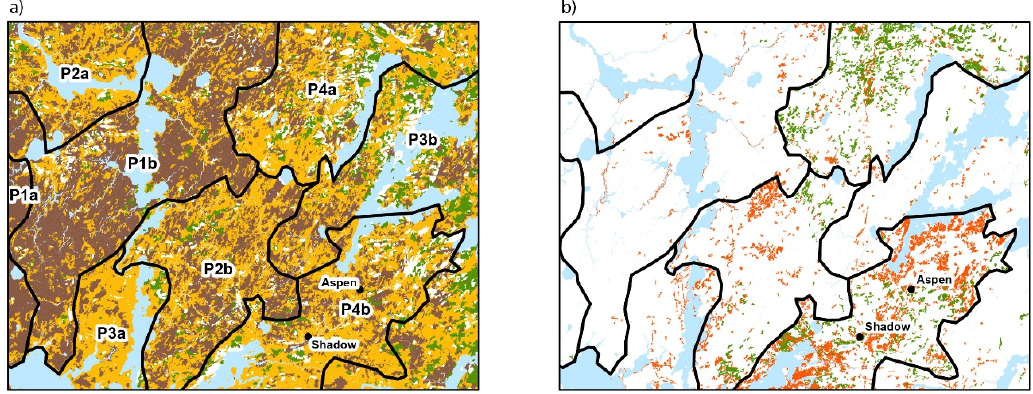
Figure 3. Delineation of the boundaries of the landscapes (P1–P4) in the study area. ( a ) Distribution of the surface deposits: organic deposits ( brown ), clay ( orange ) and till ( green ); ( b ) Distribution of the forest stands dominated by Populus tremuloides ( orange ) and Pinus banksiana ( green ). Aspen and Shadow peatlands are located in landscape P4b. The information on surficial deposits and forest cover was compiled from QMFFP forest maps. The description of the landscapes is presented in Table S1.